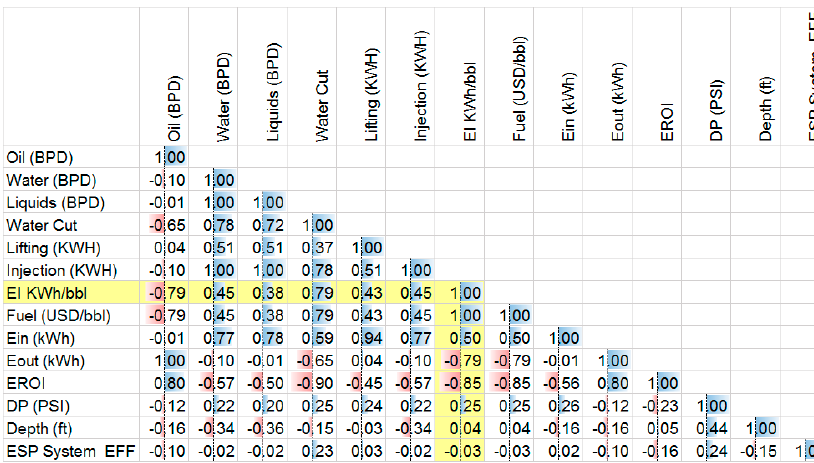
Figure 12. Water cut plotted against fuel costs.